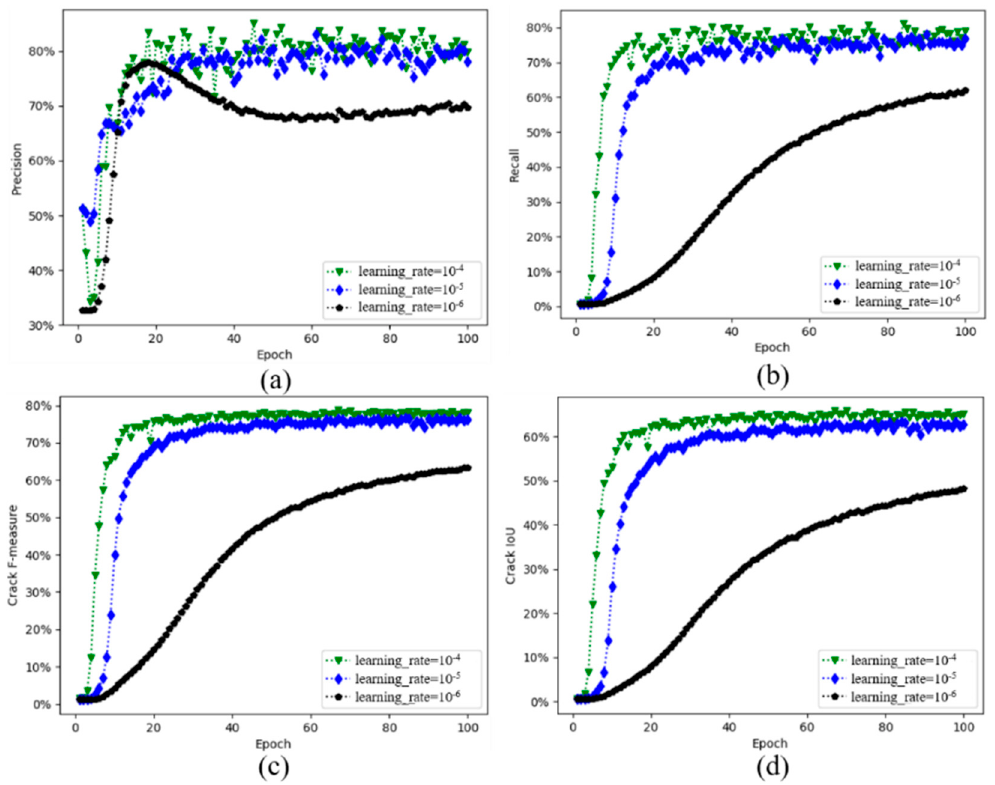
Figure 10. Evaluation indicators on validation dataset: ( a ) Precision, ( b ) Recall, ( c ) F-measure, ( d ) Crack IoU.